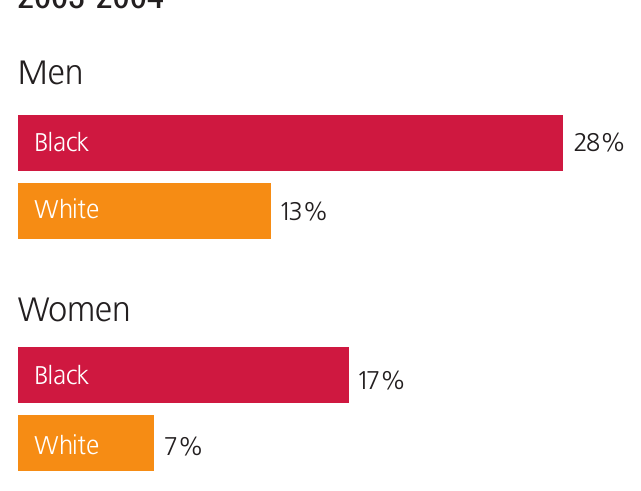
Figure 5. Rates of investigatory traffic stops among Kansas City drivers under age 25,